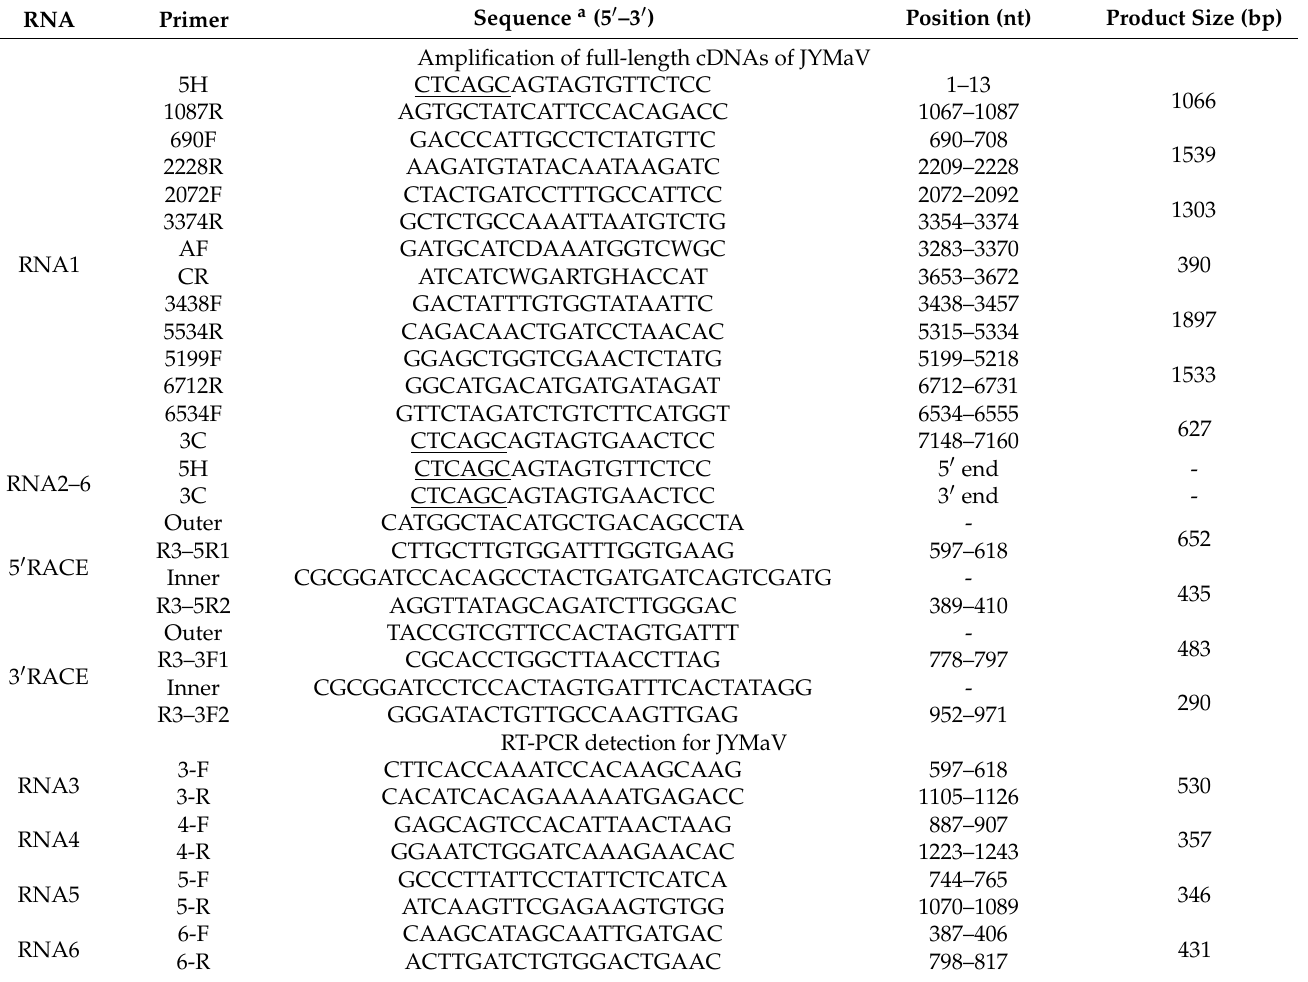
Table 1. Primers used for the amplification of full-length cDNAs of JYMaV RNAs from sample HZ and RT-PCR detection for JYMaV in jujube